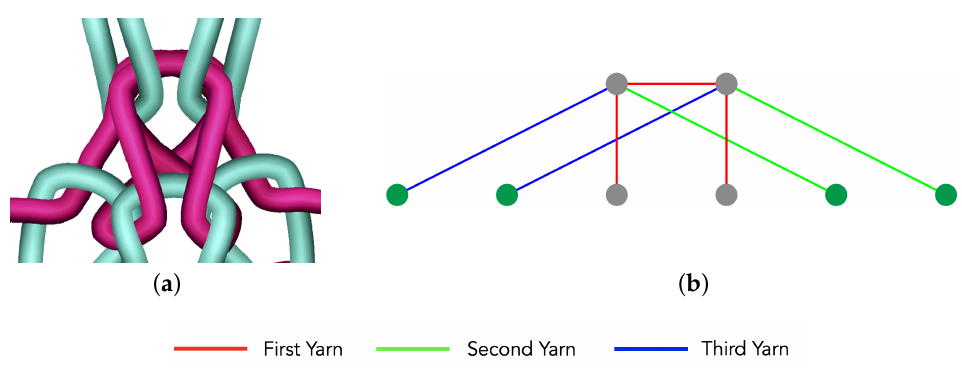
Figure 15. Yarn order zoom-in at location (6, 5) in the yarn topology graph of Figure 11: ( a ) Simulated knitted pattern. ( b ) Corresponding zoom-in topology